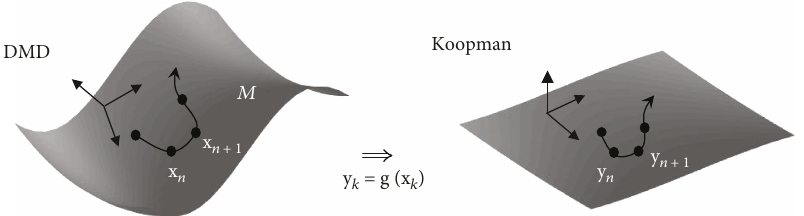
in (2) generates a solution. DMD t